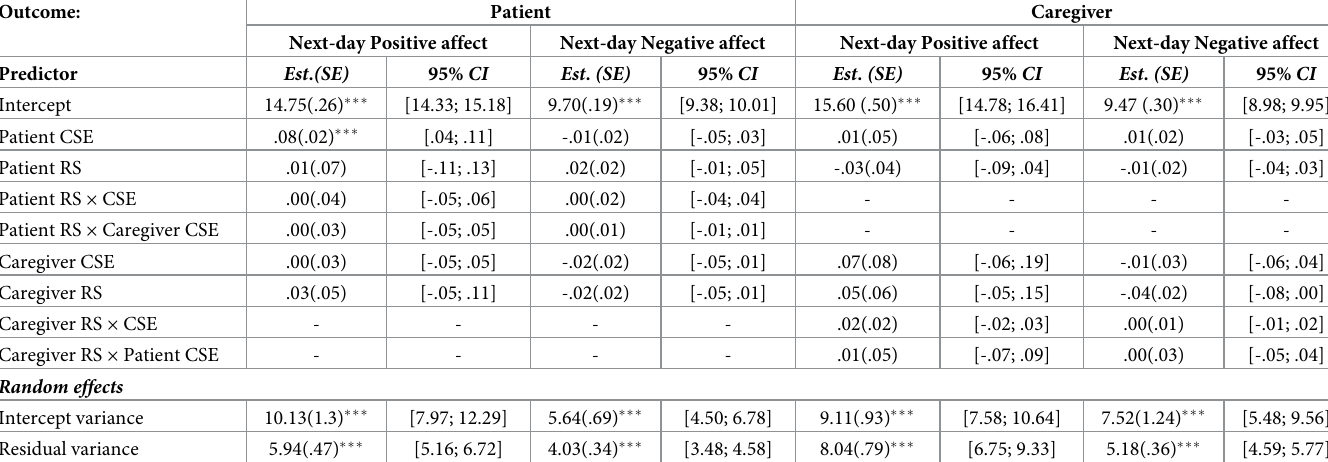
Table 3. Results of lagged analysis: The fixed effects of daily coping self-efficacy (CSE), received support (RS), and their interaction on next-day affect in 200 patient-caregiver dyads. Outcome: